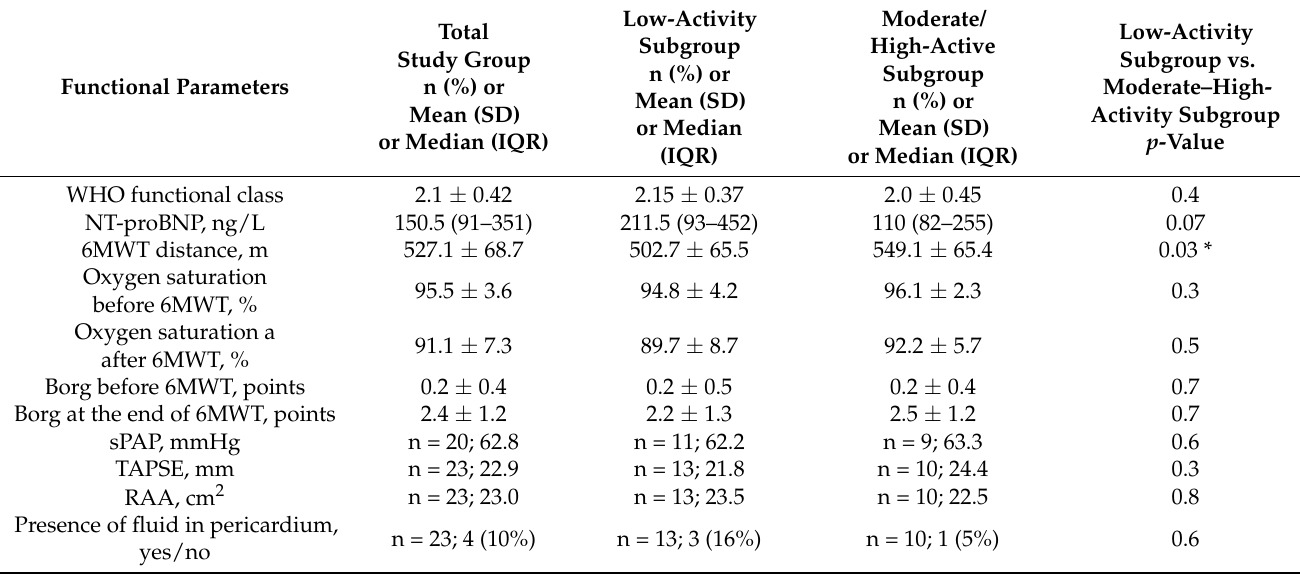
Table 2. Baseline characteristics of the study group.